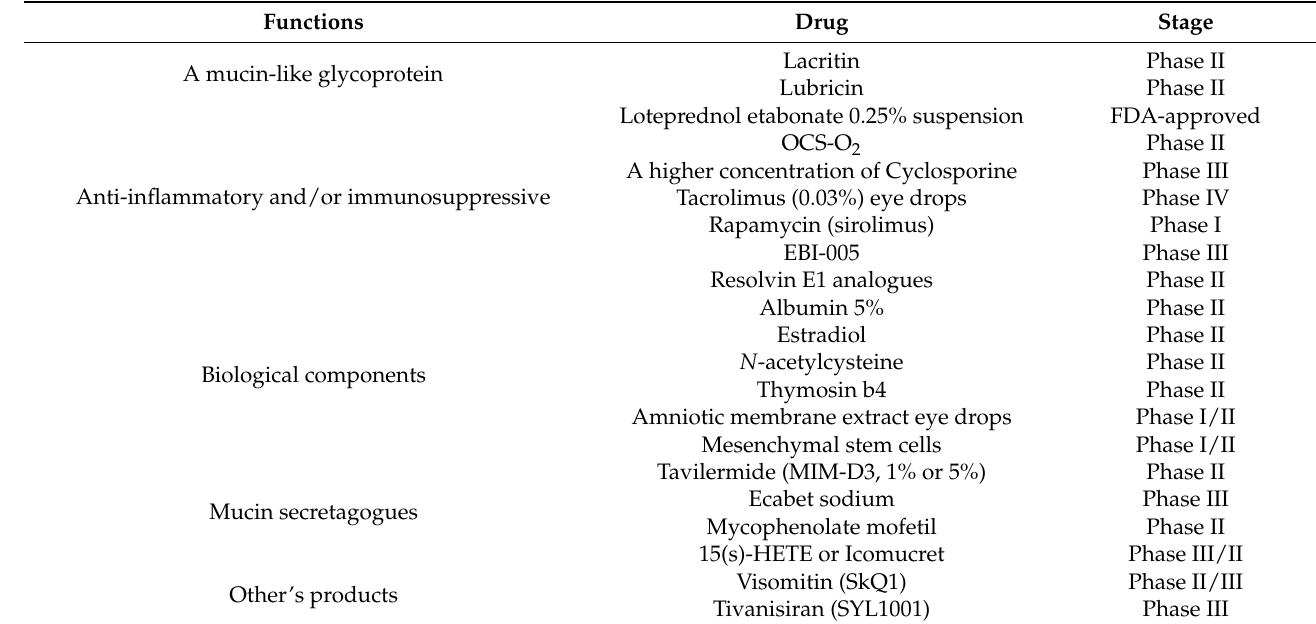
Table 2. Clinical trials of DED drugs [59]. Copyright 2022